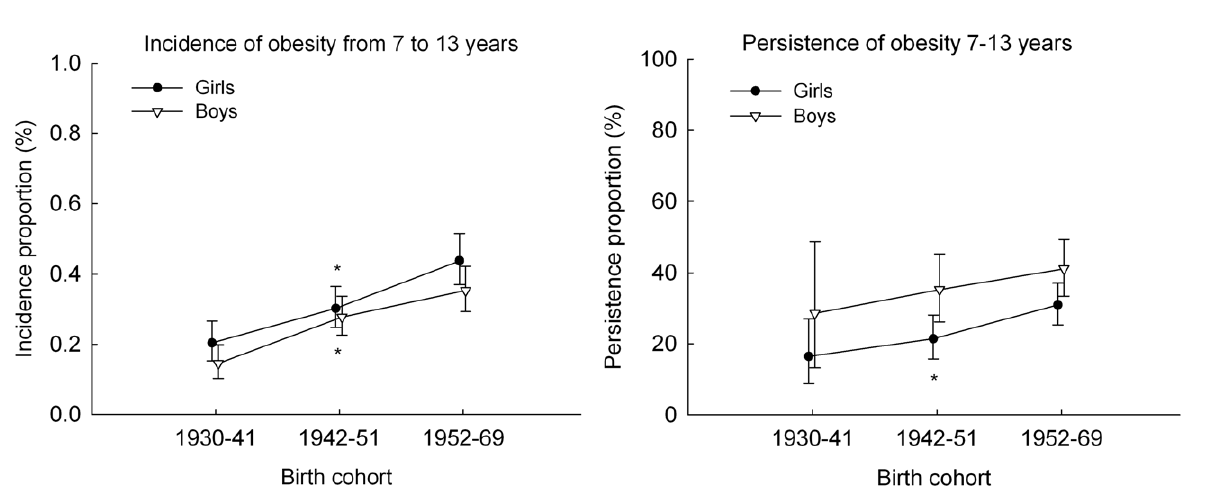
Figure 3. Trends in the incidence and persistence proportion of obesity. The figure shows trends in the incidence (left panel) and persistence (right panel) proportion of obesity (percent with 95% confidence intervals) from age 7 to 13 years by birth cohort (1930–69) among children in the Copenhagen School Health Records Register. Note that in the left panel the range on the y-axis is truncated at 1%. The analysis of incidence is based on 96 558 boys and 95 636 girls who were non-obese at age 7 years. P values for non-linearity were 0.41 among boys and 0.63 among girls. The p value for linearity was , 0.001 among both boys and girls. The analysis of persistence is based on 291 boys and 507 girls who were obese at age 7 years. Obesity was defined by International Obesity Task Force criteria. P values for non-linearity were 0.96 among boys and 0.60